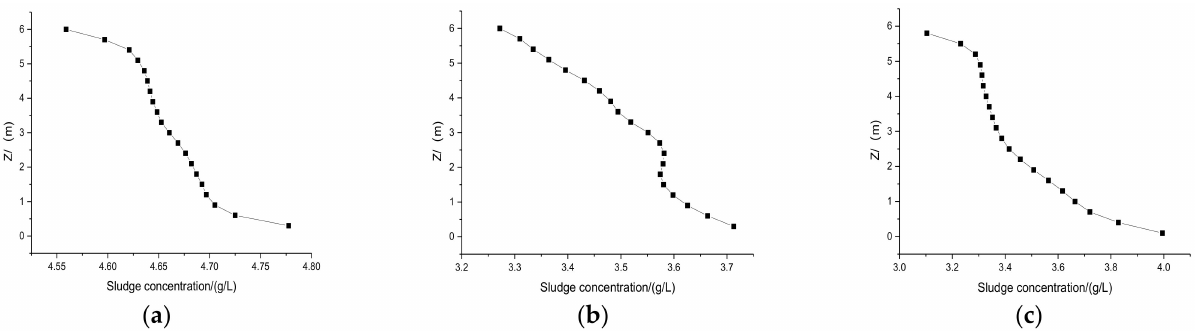
Figure 7. Curves of average velocity at each section. ( a ) Biological selection pool; ( b ) Anaerobic pool; ( c ) Anoxic pool.